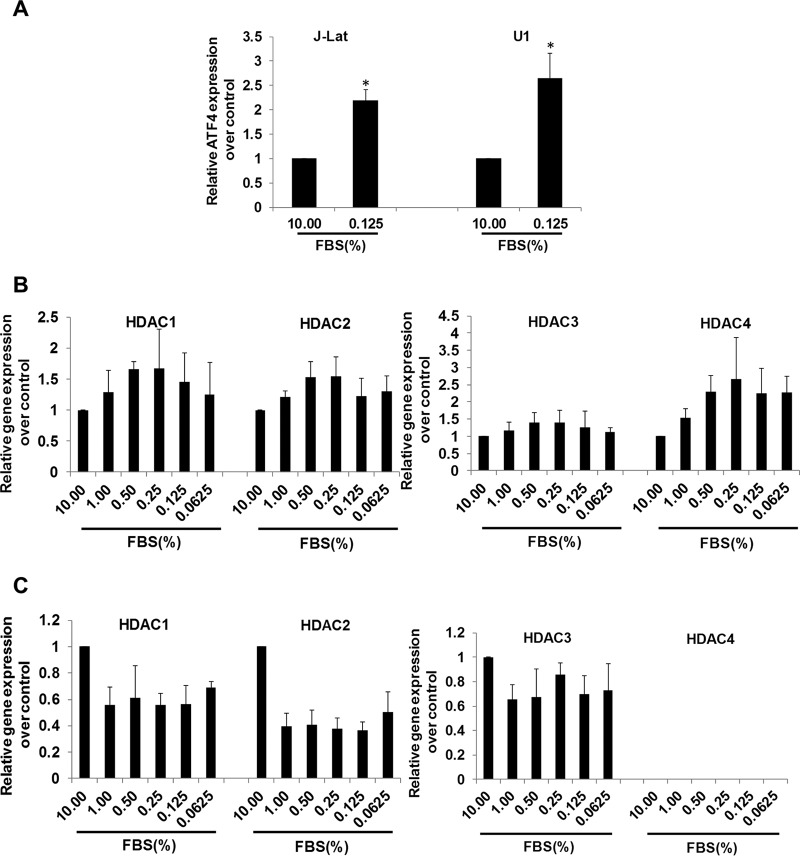
Nutrient deficiency induces ATF4 expression in immune cells. (A) ATF4 expression was induced after nutrient deprivation in both J-Lat A1 cells and U1 cells. J-Lat A1 cells or U1 cells were nutrient deprived for 48 h, and ATF4 expression was evaluated by RT-qPCR. *, P < 0.05; **, P < 0.01. (B and C) The J-Lat A1 cells (B) and U1 cells (C) were nutrient deprived in medium with low levels of serum (10% to 0.0625%) for 48 h, and HDAC1 to HDAC4 gene expression was evaluated by RT-qPCR. Experiments were performed a minimum of three times.